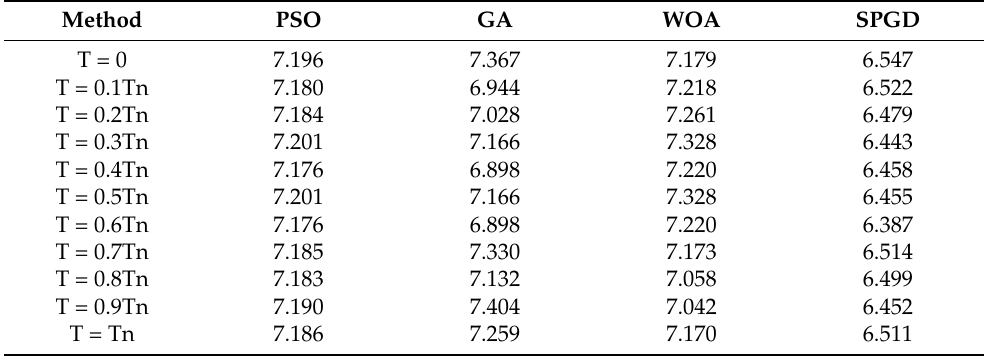
Table 5. The relative error of each method under the high-order harmonics at different load moments.